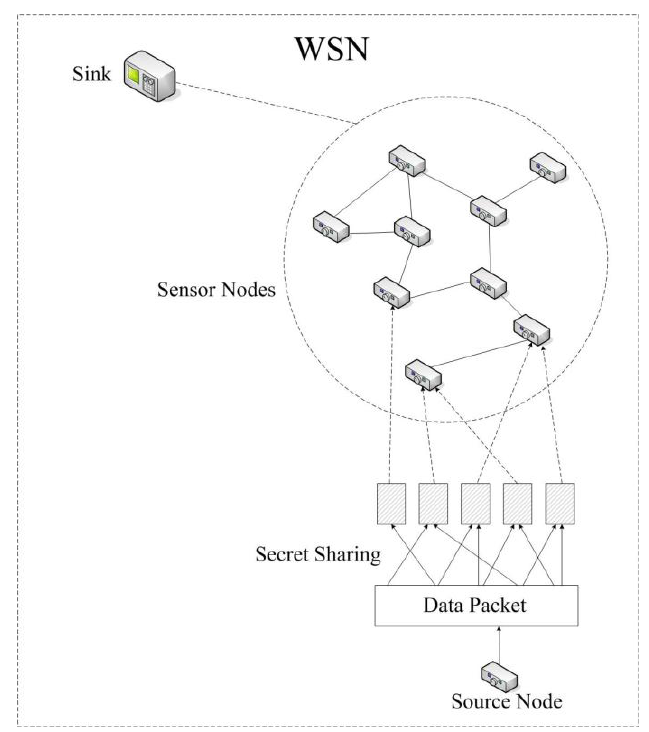
Figure 1. A WSN with secret sharing mechanism for data collection.